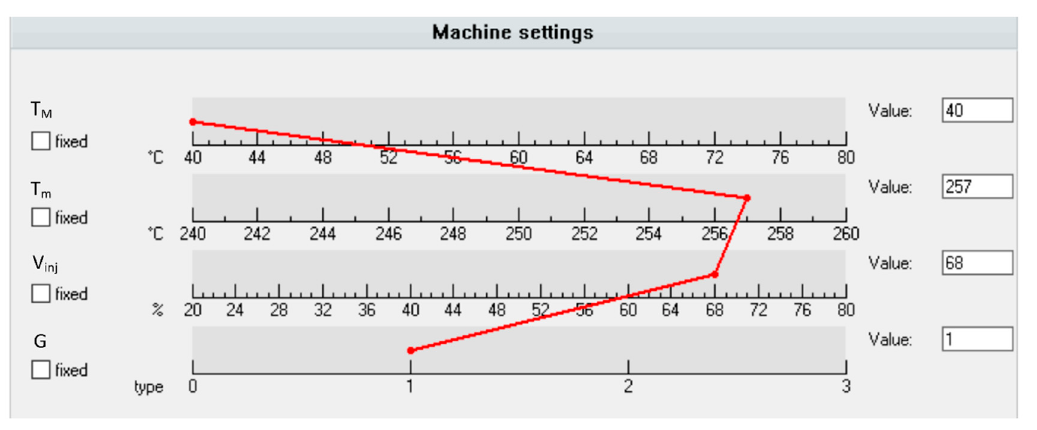
Figure 11. Optimization criteria for optimal setting with respect to predefined range: ( a ) I m —imbalance ( b ) P inj —injection pressure, ( c ) T molding —molding temperature, ( d ) t inj —injection time. Figure 12 presents simulation and experimental results for optimum set of data. It is clearly seen that the imbalance is relatively low, and equal to about I m = − 9%, which means the outer cavities are filled faster.